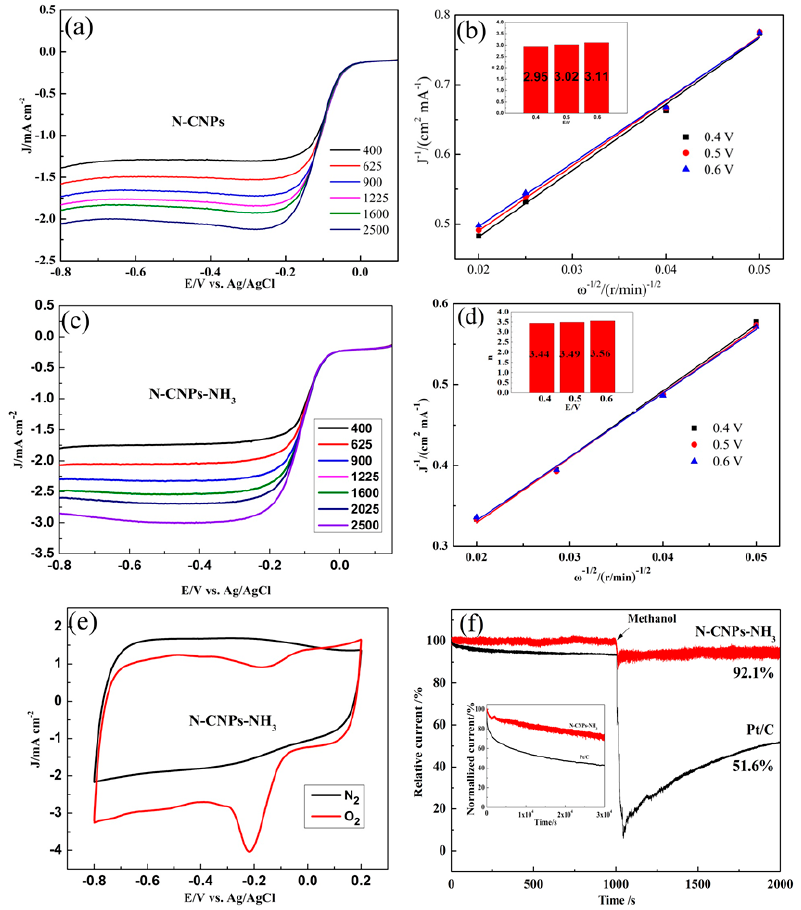
Figure 3. ( a ) LSV curve and ( b ) K–L plots of N-CNPs; ( c ) LSV curve and ( d ) K–L plots of N-CNPs-NH 3 . Inset: corresponding transferred electron numbers of N-CNPs and N-CNPs-NH 3 . CV curves of N-CNPs and N-CNPs-NH 3 in 0.1 M KOH solutions at a scan rate of 50 mV/s. RDE voltammograms of: ( e ) commercial 20 wt % Pt/C, N-CNPs, and N-CNPs-NH 3 in a O 2 -saturated 0.1 M KOH solution (rotation speed 1600 rpm); ( f ) I–t curves of N-CNPs-NH 3 and Pt/C at 0.25 V in a O 2 -saturated 0.1 M KOH solution (400 rpm) with or without addition of a 3.0 M methanol solution. Inset: I–t curves of N-CNPs-NH 3 with a rotation speed of 400 rpm under constant voltage (0.25 V) for ca. 30,000 s.